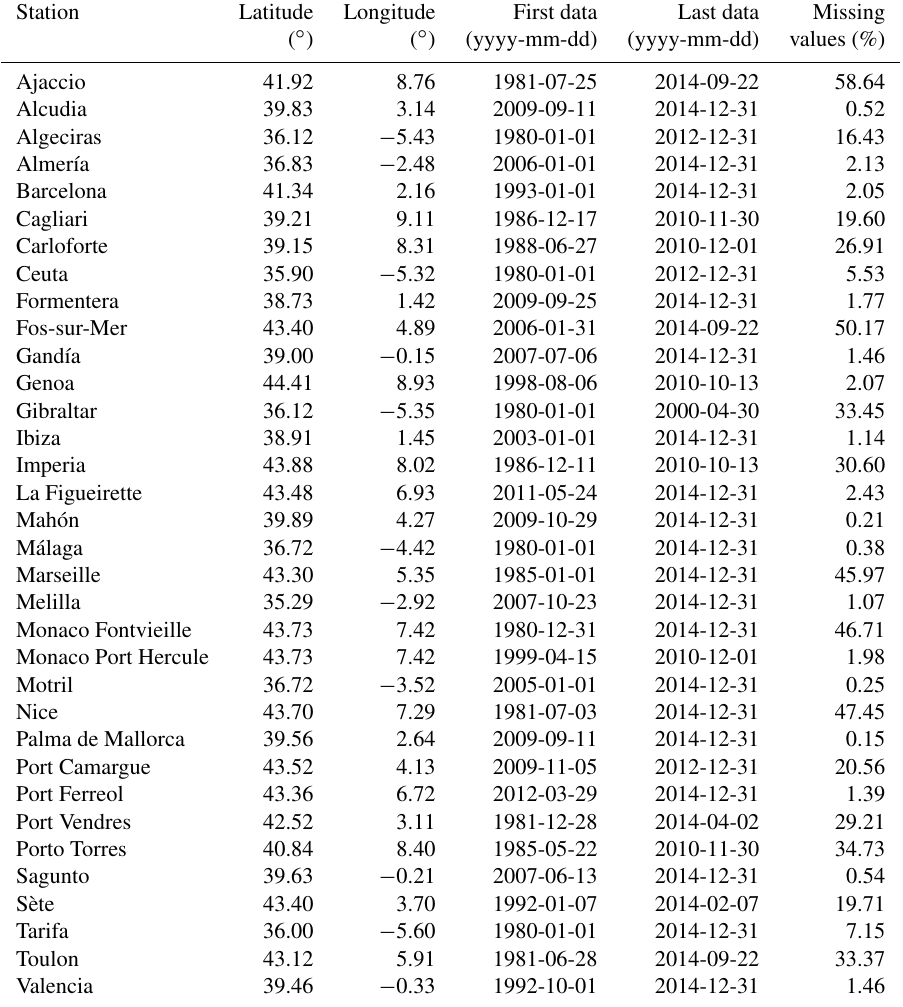
Table 1. GESLA-2 tide gauges in the western Mediterranean basin, including their location, the start and end dates of the series, and the percentage of missing